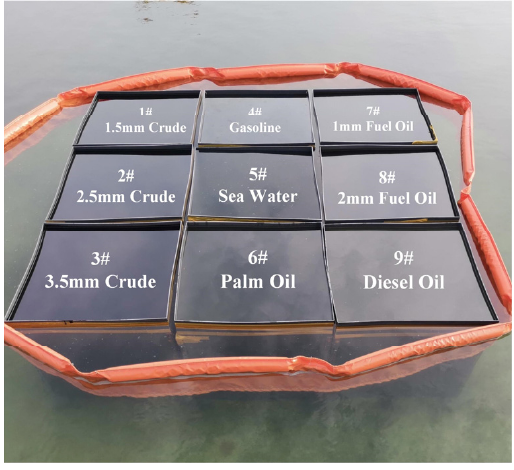
Figure 4. Oil spill experiment group labels. The oils used in this experiment are shown in Figure 5. From left to right are crude oil from the Dongying Shengli Oilfield, fuel oil, edible palm oil, diesel (#0), and gasoline (#95). The heavy-oil experimental groups included crude oil and fuel oil, and the light-oil experimental groups included palm oil, diesel, and gasoline.